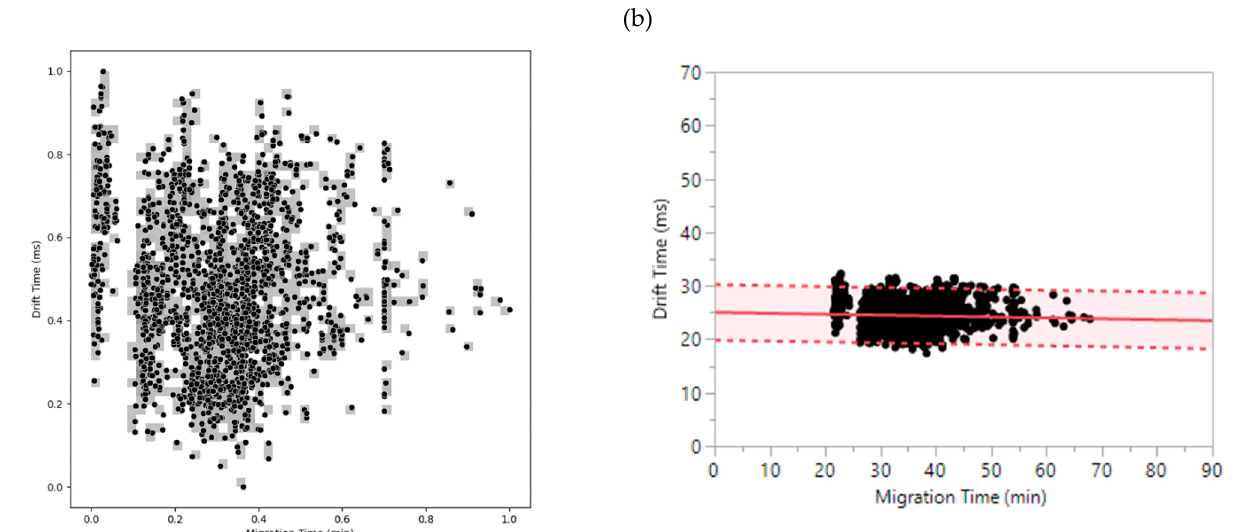
Figure 6. Orthogonality between CZE and DTIMS using methods 1 and 2. ( a ) Method 1: Plot illustrating the coverage of separation space by peptides through shaded bins. ( b ) Method 2: Plot illustrating the distribution of peptides around the regression line. The pink section indicates the separation space occupied by peptides.